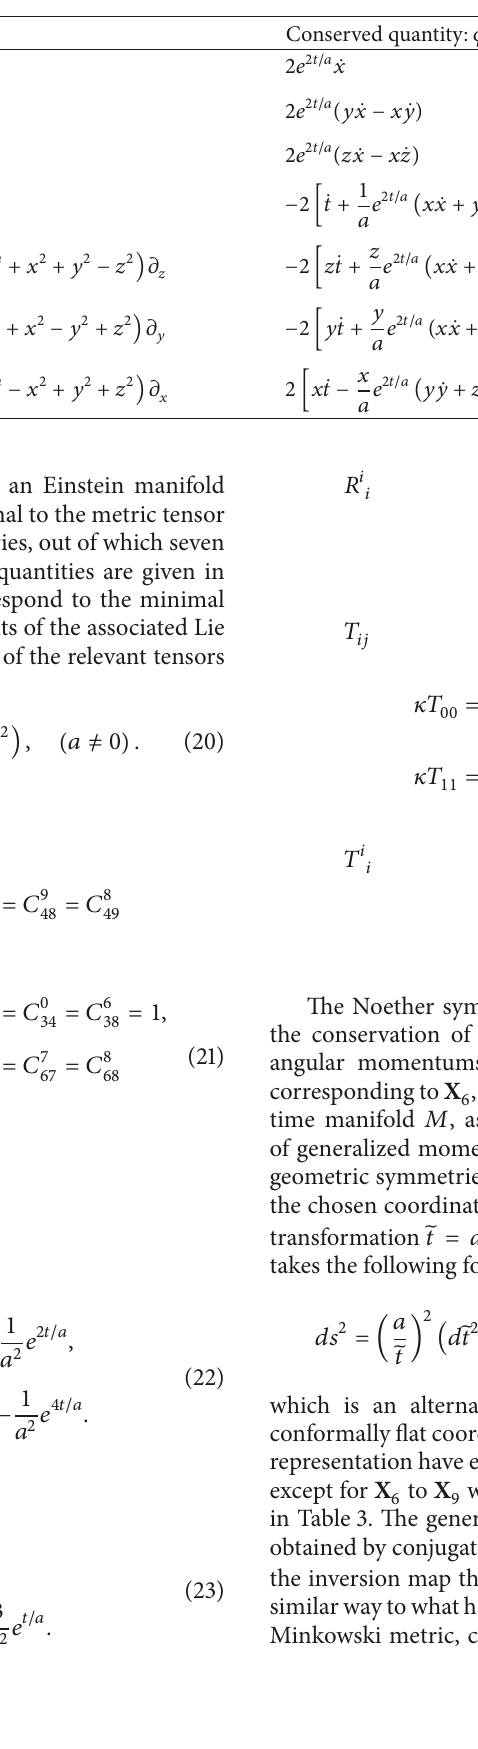
Table 2: Conserved quantities corresponding to each Noether